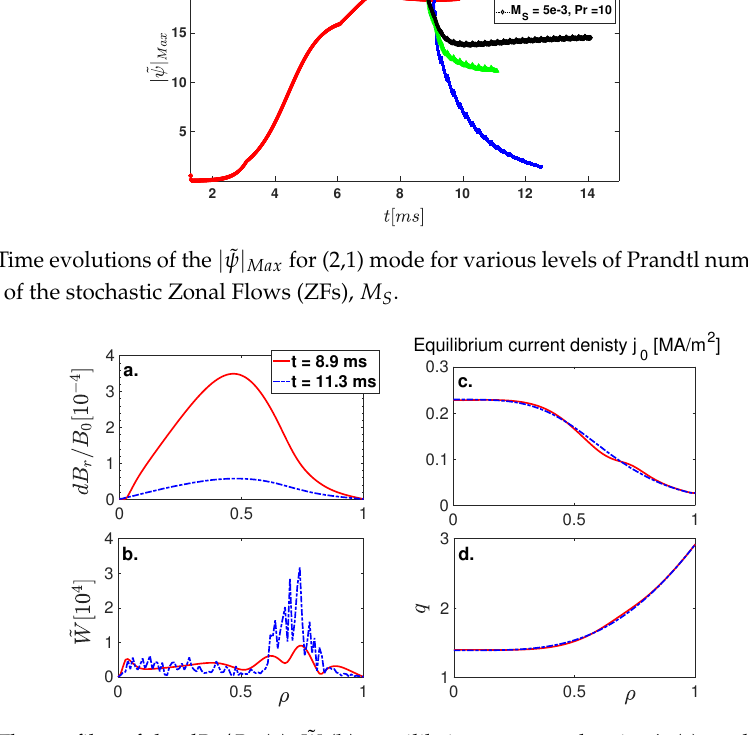
Figure 2. The profiles of the dB r / B 0 ( a ), ˜ W ( b ), equilibrium current density j 0 ( c ), and safety factor q ( d ) for the (2,1) mode case, at time t = 8.9 ms corresponding to M S = 0 (red solid lines), and t = 11.3 ms corresponding to M S = 10 − 2 (blue dotted